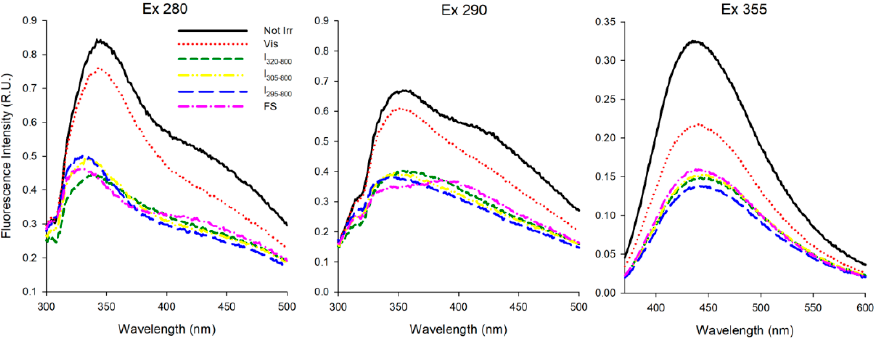
Figure 3. Fluorescence emission spectra at 280, 290 and 355 nm excitation wavelength (Ex 280, Ex 290, and Ex 355, respectively) of CDOM released by E. huxleyi before and after irradiation with the different cutoff filters. For each treatment the spectrum shown is the average spectra of the replicates. Note the difference in the scale of both axes.